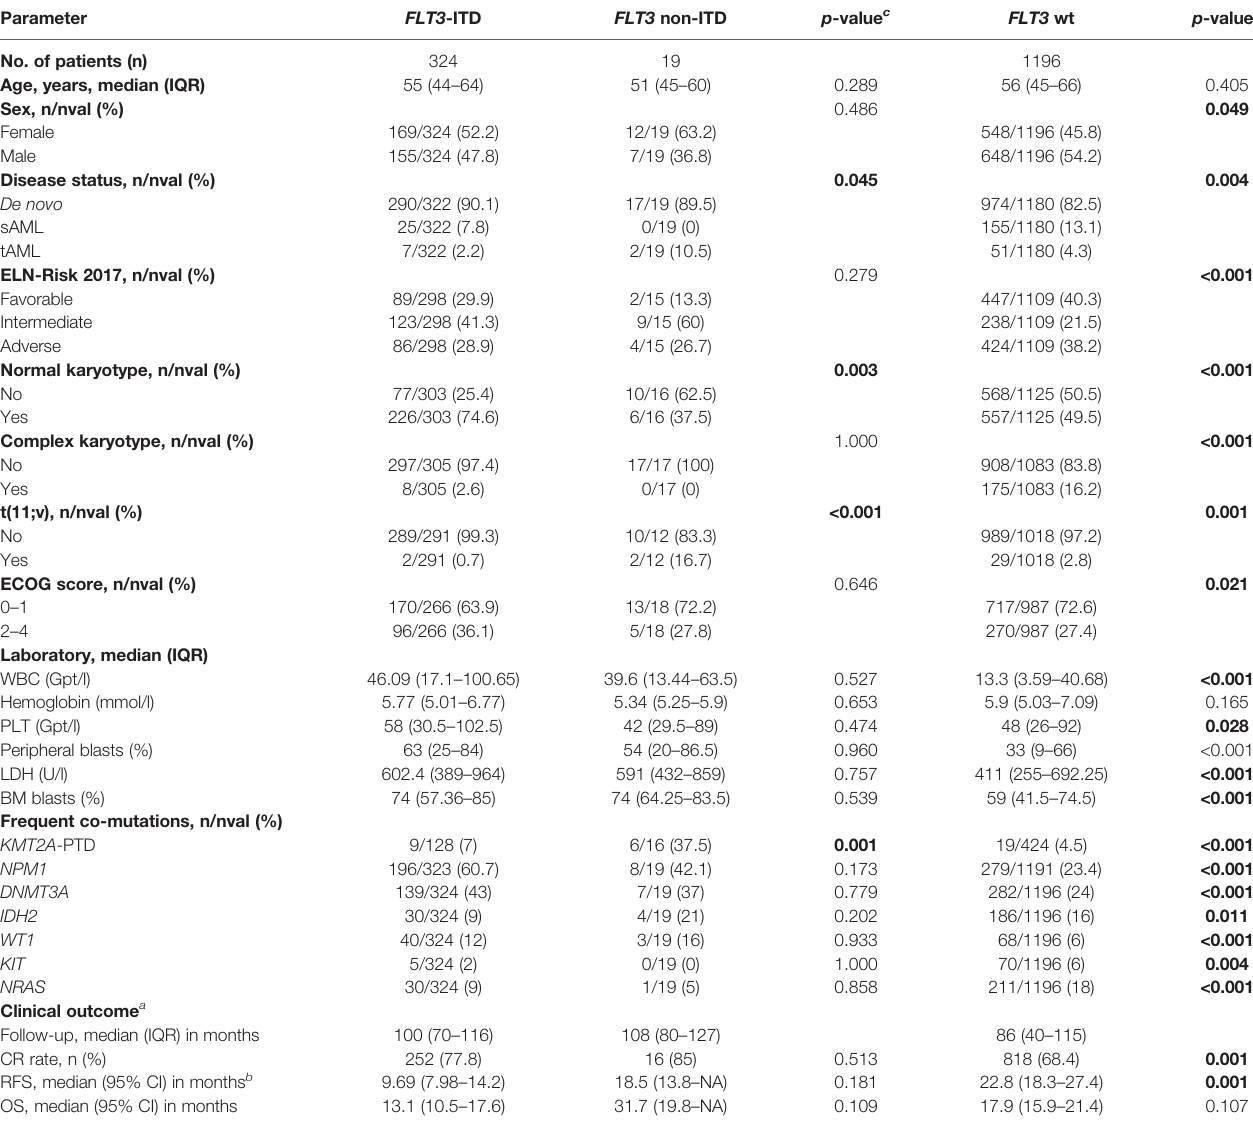
TABLE 1 | Clinical and molecular characteristics of patients.